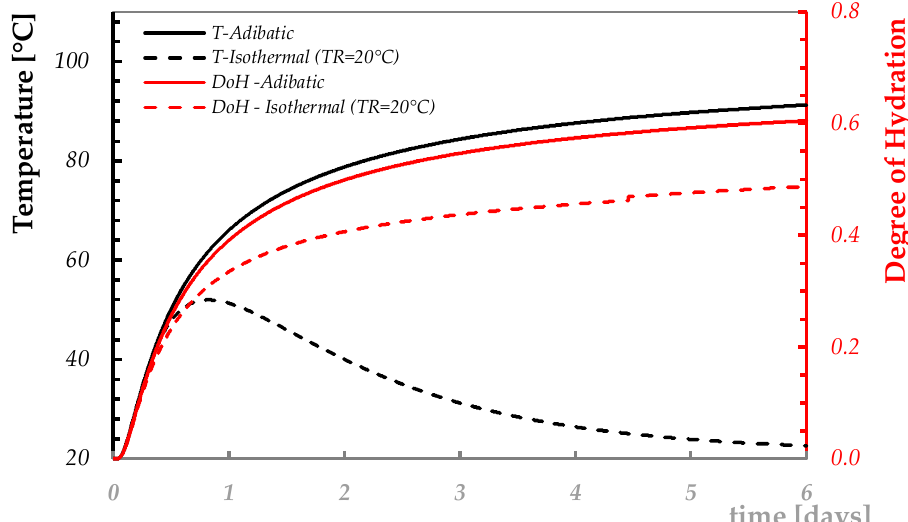
Figure 4. Representative simulation of the time evolution of temperature (principal vertical axes) and degree of hydration (secondary vertical axes) in adiabatic and isothermal conditions within a concrete element.